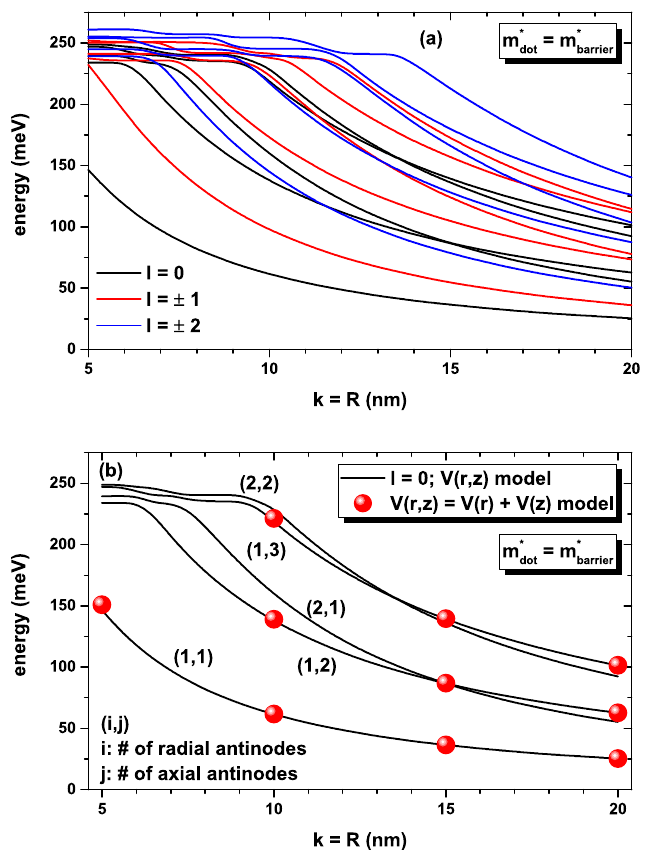
Figure 2. The lowest energies for a confined electron within the CQD as a function of the simultaneous variation of the k -width in the axial direction and the R -radius in the radial direction. Calculations are for zero applied electric field and using the model V 1 ( z ) = V 0 sinh 2 potential (see Equation (7)). In ( a , b ), the solid lines correspond to the results obtained by the solu- tion of the full non-separable V ( ρ , z ) confinement potential (this means that they are obtained by solving the 2D-axi-symmetric differential equation). In ( a ), the five lowest solutions are reported for l = 0, ± 1, ± 2. In ( b ), the full symbols are obtained by the approximation V ( ρ , z ) = V ρ ( ρ ) + V 1 ( z ) us- ing only the first solution for the radial differential equation. In ( b ), the (i,j) labels identify the number of wave function antinodes, both in the radial (i) and axial (j)